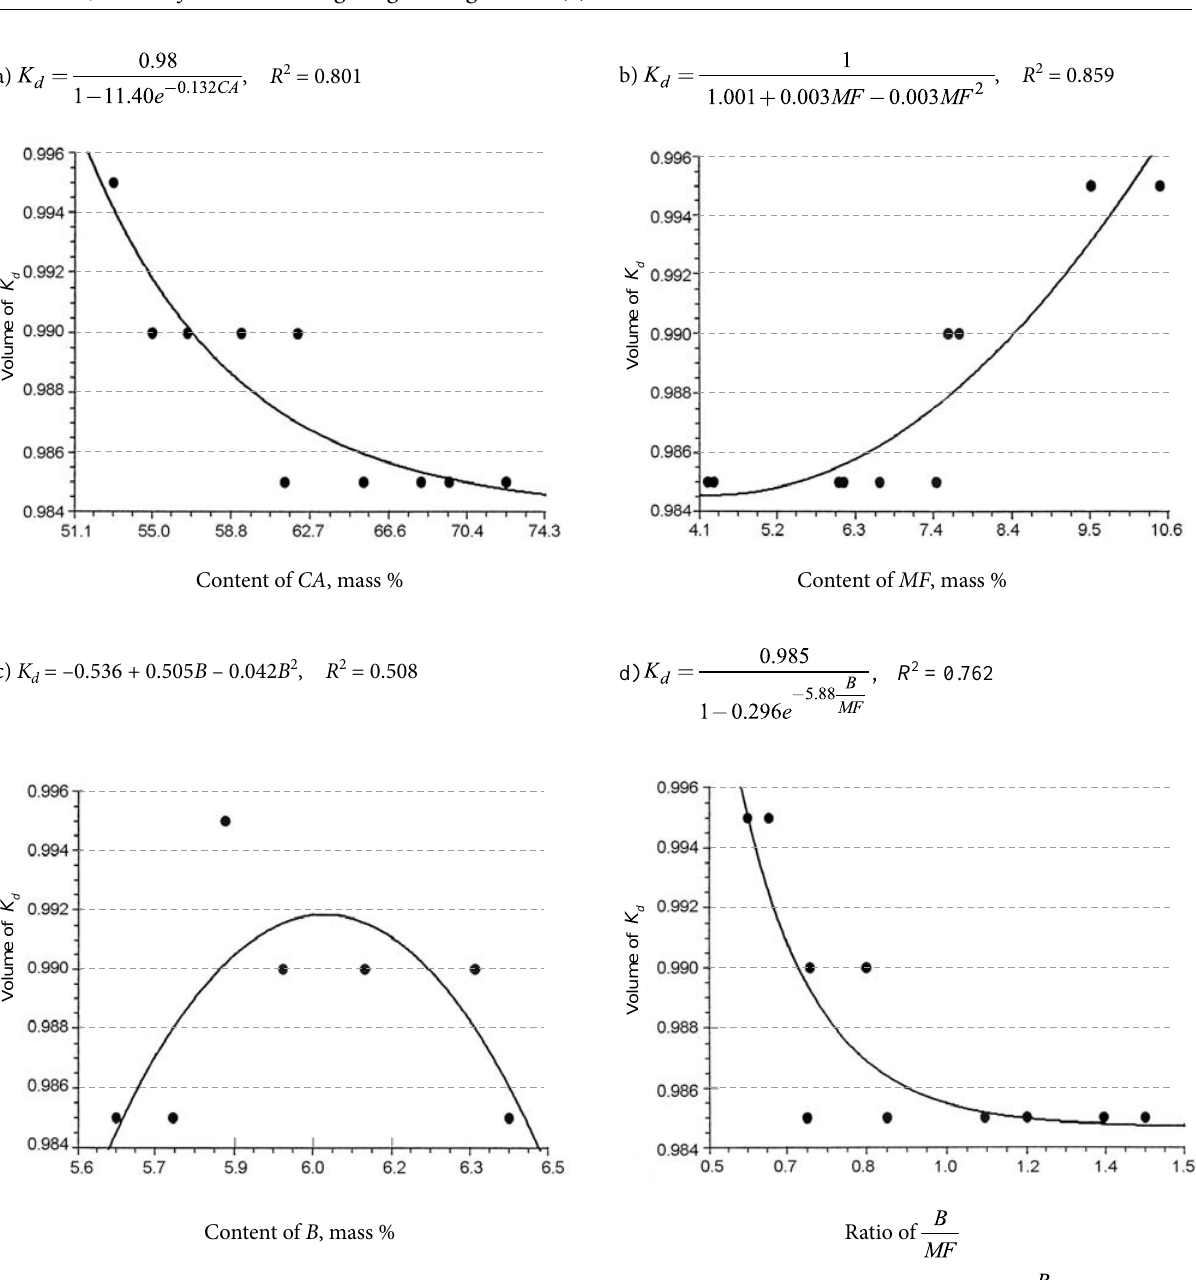
Fig. 2. Relationship between K d in motor road pavement and contents of its components: a – CA ; b – MF ; c – B ; d